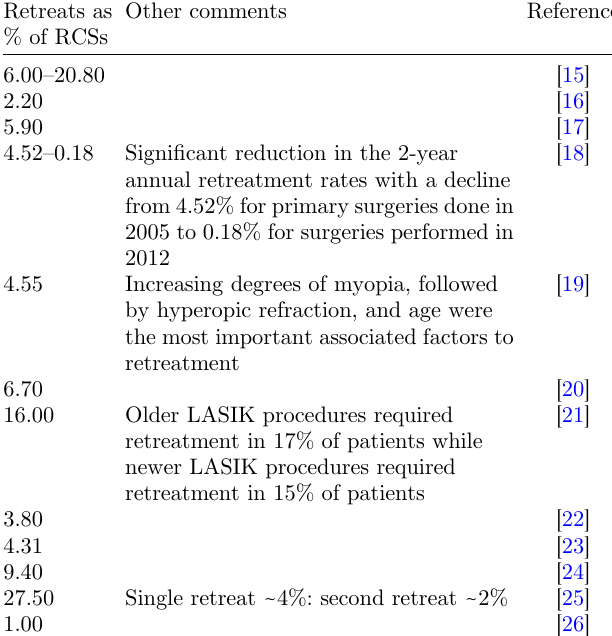
Table 1. Representative list of studies from around the world, conducted during the last decade, of RCS that required